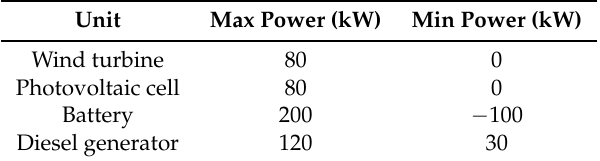
Figure 5. The transmission network of the test microgrid system. Table 4. Numerical data of distributed generations in the microgrid